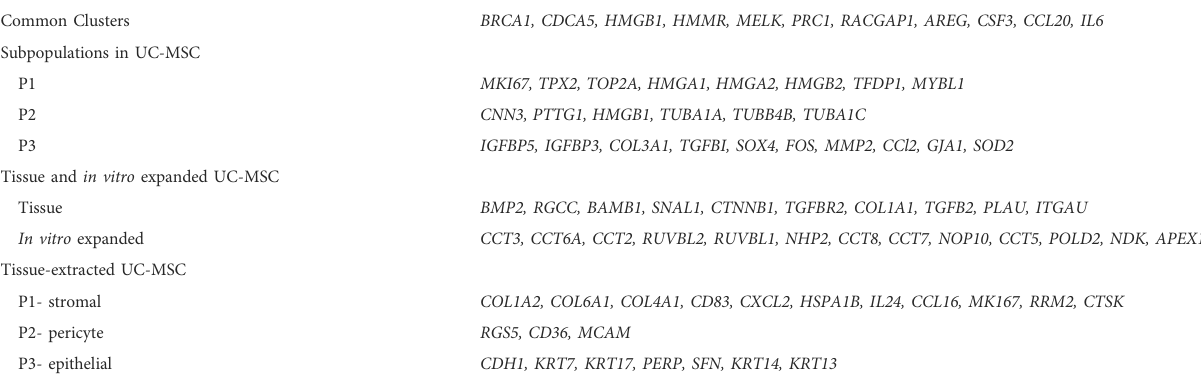
TABLE 2 Genomic heterogeneity among the subpopulation of cultured